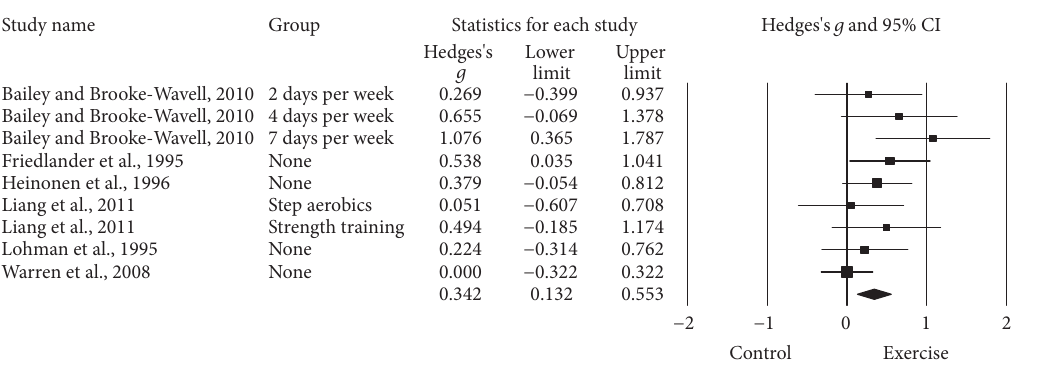
F 2: Forest plot for changes in FN BMD. Forest plot for point estimate standardized effect size changes ( represent the standardized mean difference ( intervals. e middle of the black diamond represents the overall standardized mean difference ( diamond represent the corresponding 95 groups.